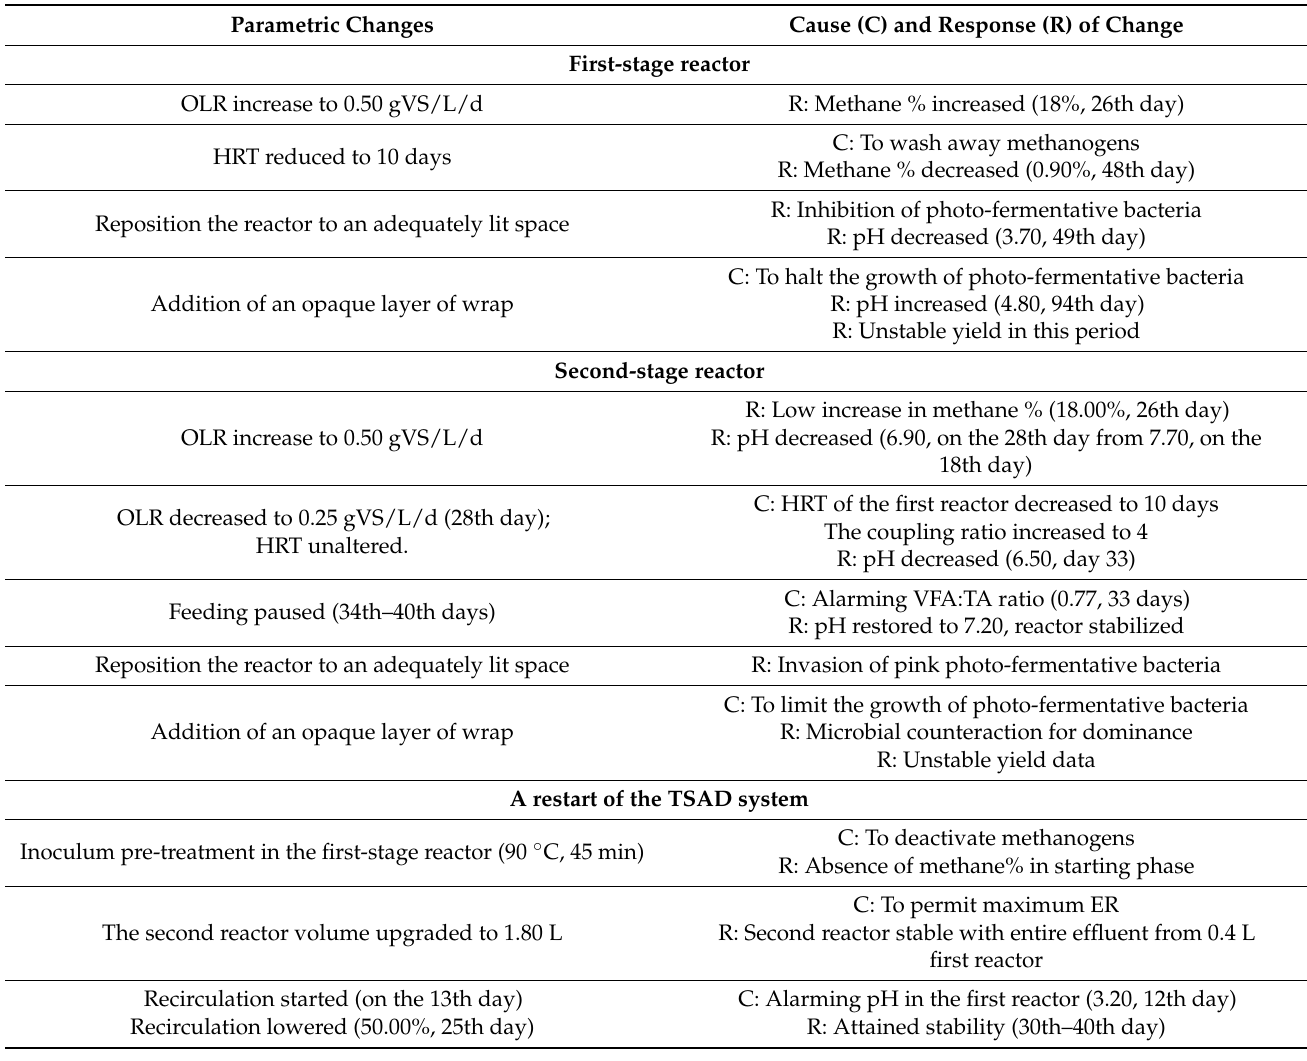
Table 2. Summary of the major parametric changes, the reason behind making the change, and the response of the TSAD system towards the